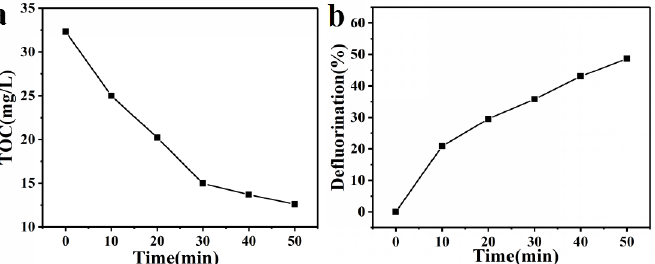
Figure 8. Variation of ( a ) TOC concentration and ( b ) the defluorination versus SFDBD plasma treat- ment time. Experimental conditions: negative pulse power; peak voltage: 15 kV; power frequency: 6 kHz; pulse width:500 ns; power: 43 W.